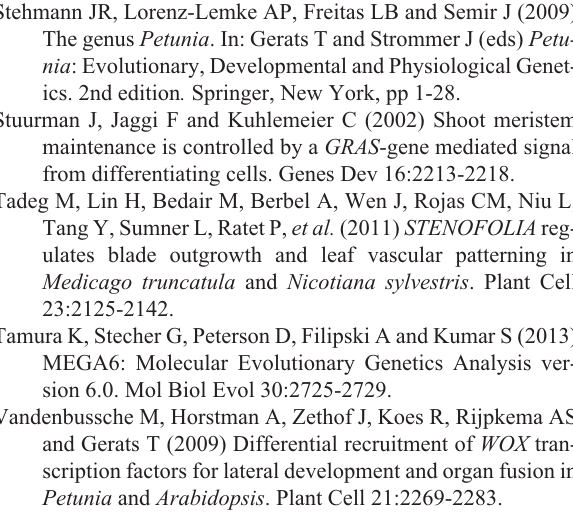
Figure S1 - Alignment of the Petunia homeodomain region of WUSCHEL -related homeobox genes. Figure S2 - Bayesian inference phylogenies of WUSCHEL -related homeobox gene sequences in Petunia species. Table S1 - Petunia WUSCHEL -related homeobox gene se- quence information. Table S2 – Sequences of the primers used in this